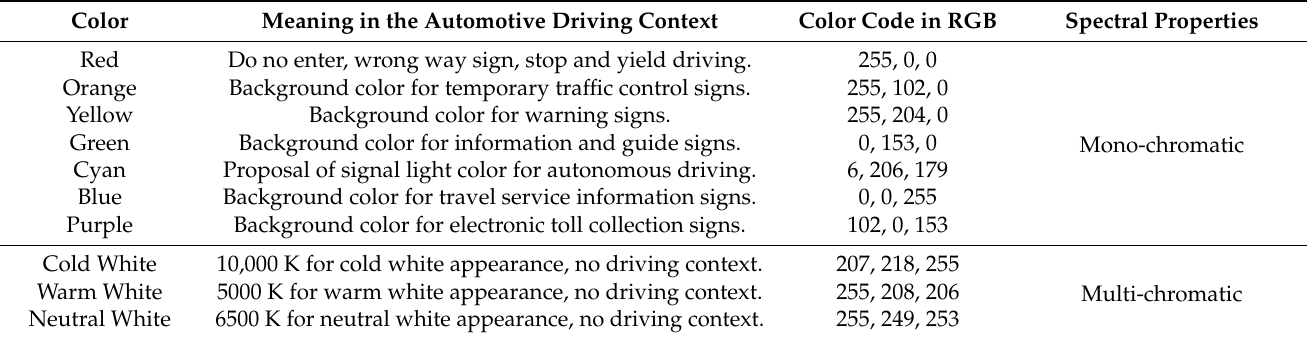
Table 1. Color settings used in the online survey